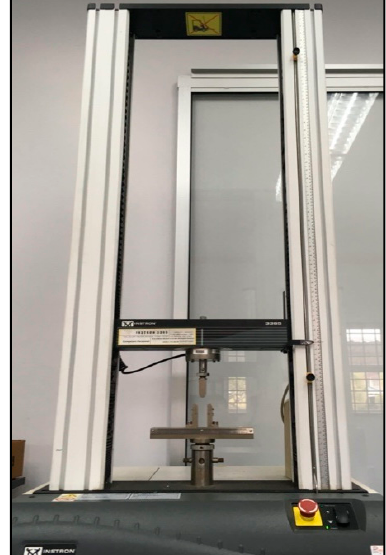
Figure 6. Flexural test setup using an Instron universal testing machine model 3365. b ca